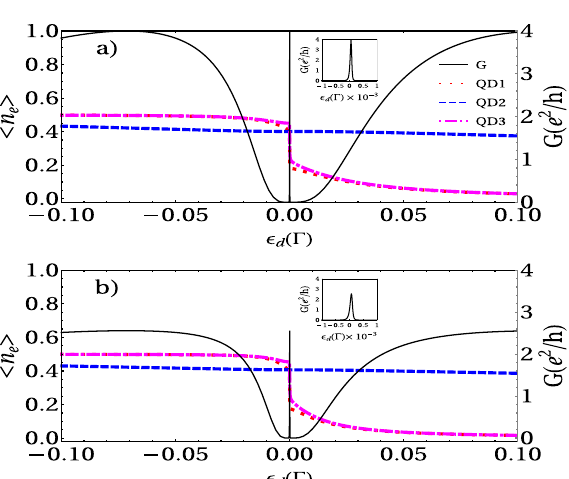
Figure 5. Electronic occupation and linear conductance of a TQD system calculated as a function of the dot’s level energy around ω